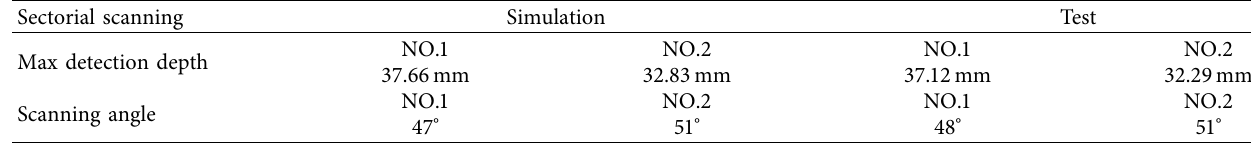
Table 3: Comparison of testing depth and scanning angle between horizontal through holes 1 and 2.